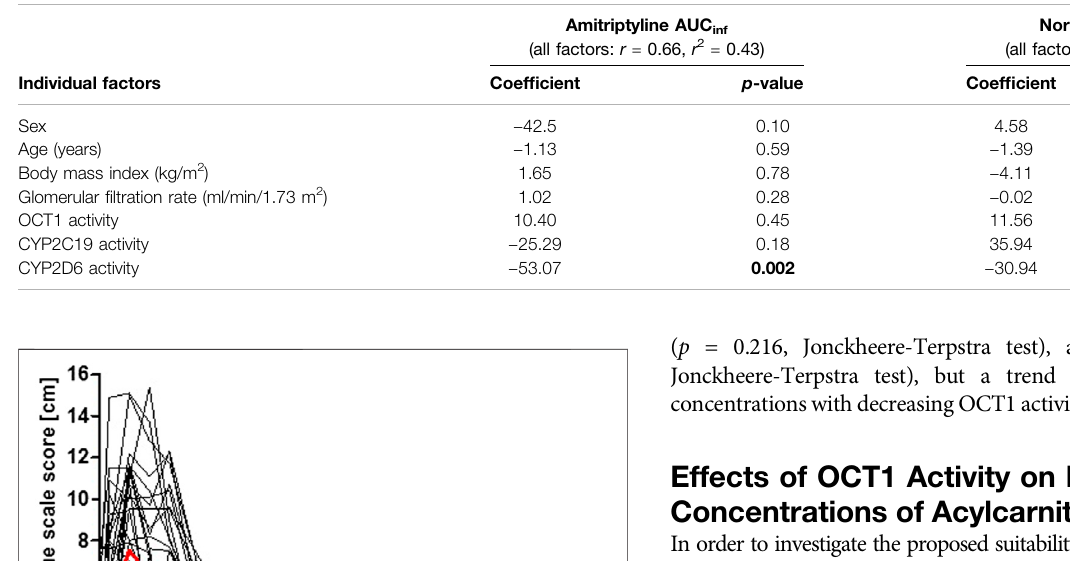
TABLE 5 | Multiple linear regression analysis to determine the individual factors that in fl uence AT and NT AUC in healthy volunteers.